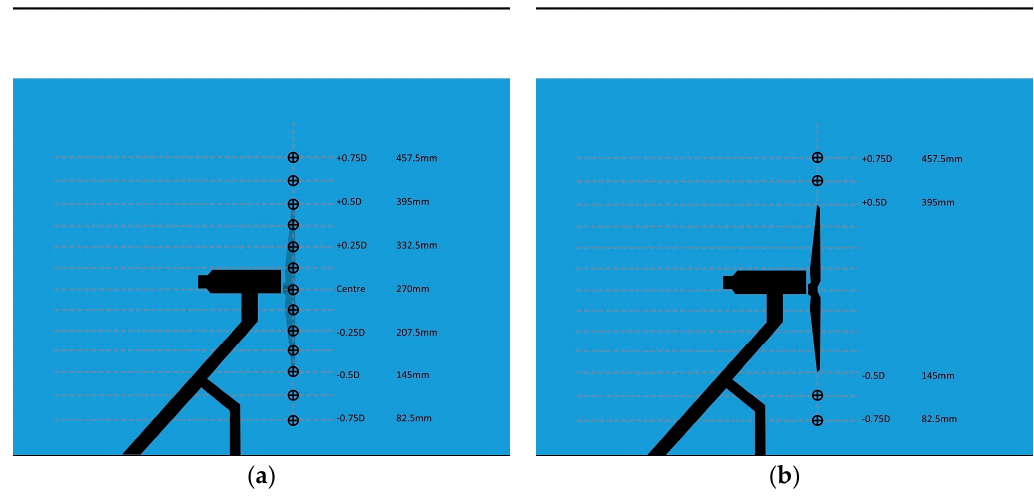
Figure 16. ADV measurement locations during blade plane tests with blades ( a ); ADV measurement locations during blade plane tests with blades ( b ).